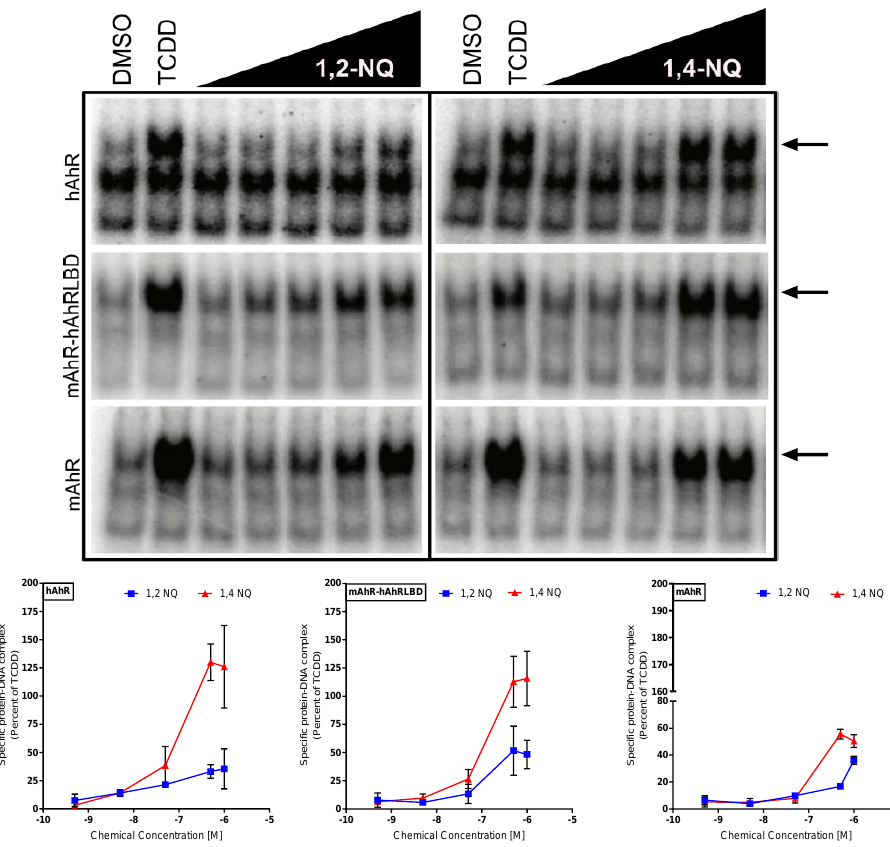
Figure 4. 1,2-NQ and 1,4-NQ directly stimulate mouse and human AhR transformation and DNA binding in vitro. In vitro synthesized hAhR, mAhR-hAhRLBD, or mAhR and hARNT or mARNT were incubated in the presence of DMSO (1%, v / v ), TCDD (20 nM), 1,2-NQ (0.5 nM–1 µ M), or 1,4-NQ (0.5 nM–1 µ M) for 2 h and protein-DNA complexes were detected by gel retardation analysis. Inducible AhR:ARNT:[ 32 P]dioxin response element (DRE) complexes (indicated by the arrows) were quantified using Fujifilm MultiGauge software and values corrected for the amount of protein: DNA complex in the presence of DMSO (control), and then normalized to the amount of complex induced by TCDD. Values represent the mean ± standard deviation of three exposure replicates and three experiments and representative gels are